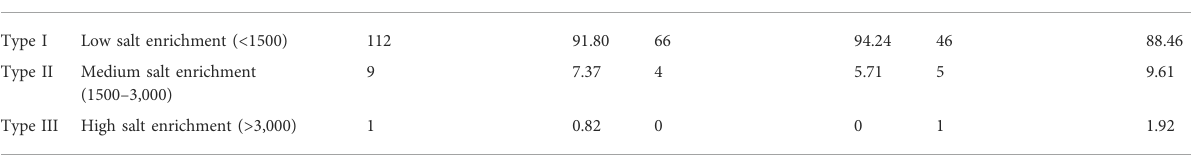
TABLE 2 Water quality assessment based on electrical conductivity (EC) (µS/cm) ( n =